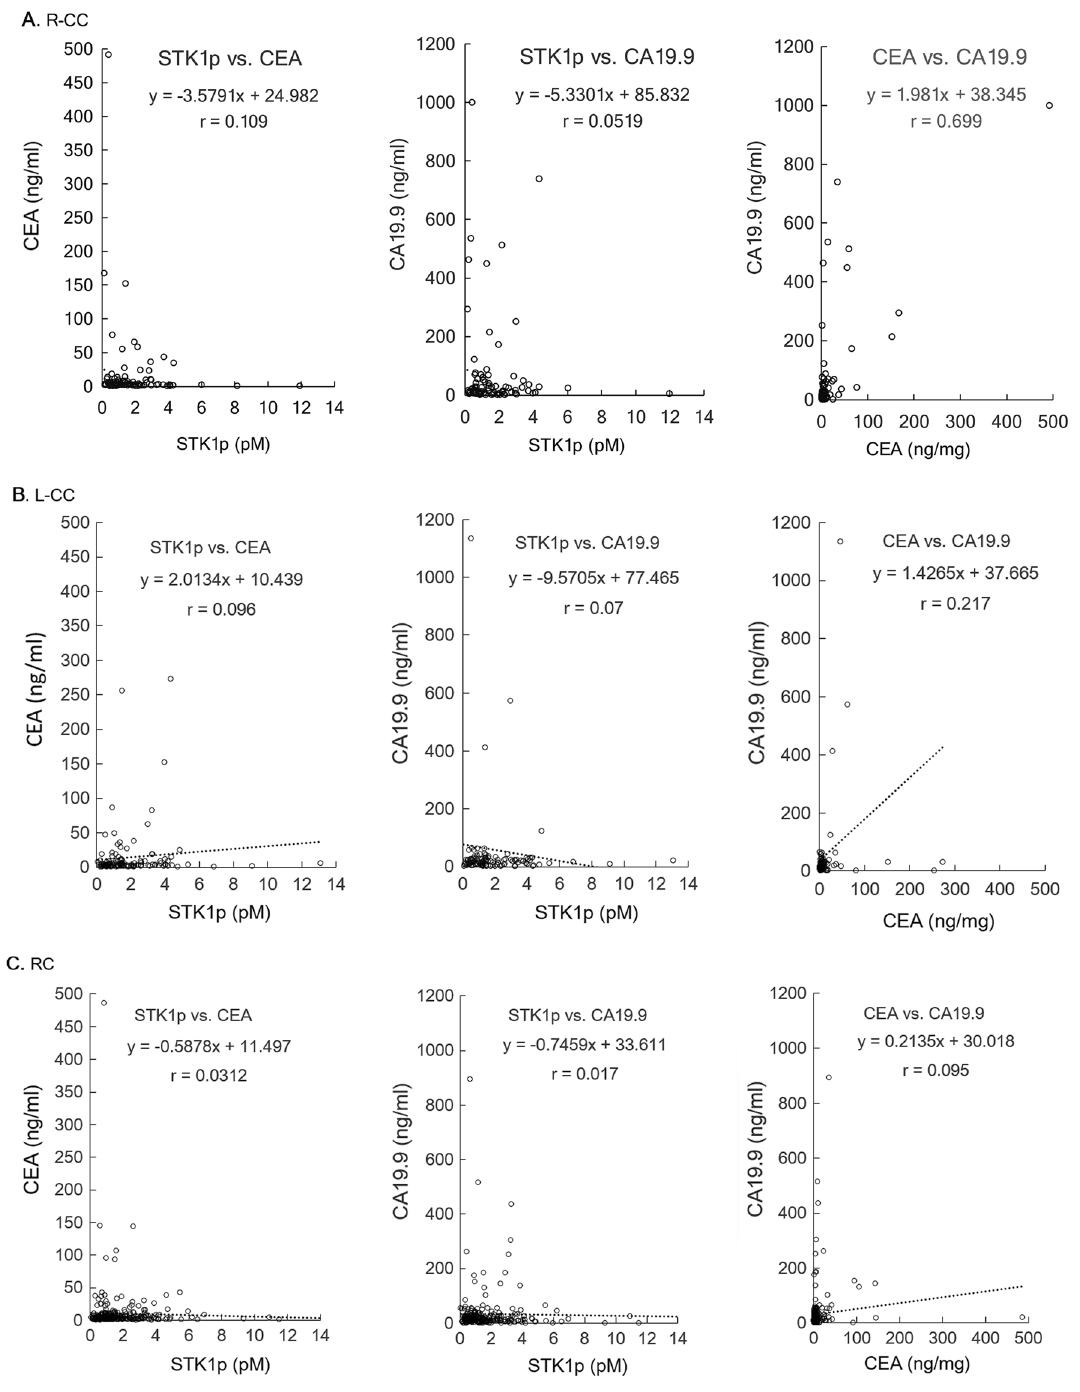
Fig. 4 Correlation between serum values of STK1p, CEA and CA19.9 in R-CC ( A ), L-CC ( B ) and RC ( C ) patients. r = Pearson correlation by the accumulation of genetic mutations and the progression of carcinogenesis [6]. The K-ras oncogene is a key factor and is the initial step in colorectal tumorigenesis. It can appear in benign polyps or in the normal accompanying mucosa polyps [37]. A strong recommendation from the European Society of Gastrointestinal Endoscopy (ESGE) Clinical Guideline is that all polyps should be resected except for diminutive (≤ 5 mm) rectal and rectosigmoid polyps that are predicted with high confidence to be hyperplastic [38]. We suggest detecting early colorectal tumorigenesis